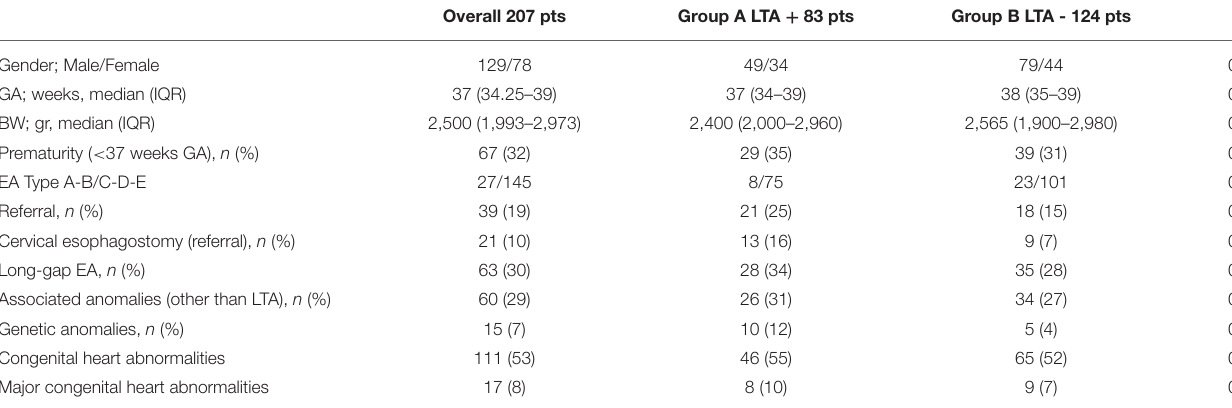
TABLE 2 | Demographic and clinical characteristics.